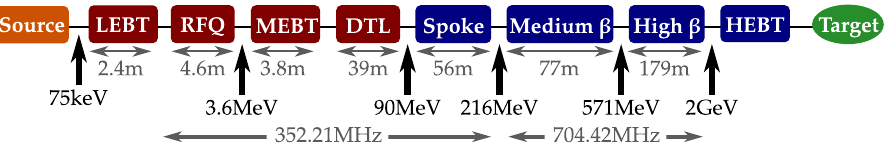
FIG. 1. A block diagram of the ESS linac [1,2]. The normal-conducting (NC) linac is composed of an ion source, radio frequency quadrupole (RFQ), drift tube linac (DTL), low (LEBT) and medium energy beam transport (MEBT) sections. Spoke resonators, medium beta and high beta elliptical cavities together with high energy beta transfer (HEBT) line constitute the superconducting (SC) linac. Red and blue color refer to NC and SC parts of the linac, respectively.